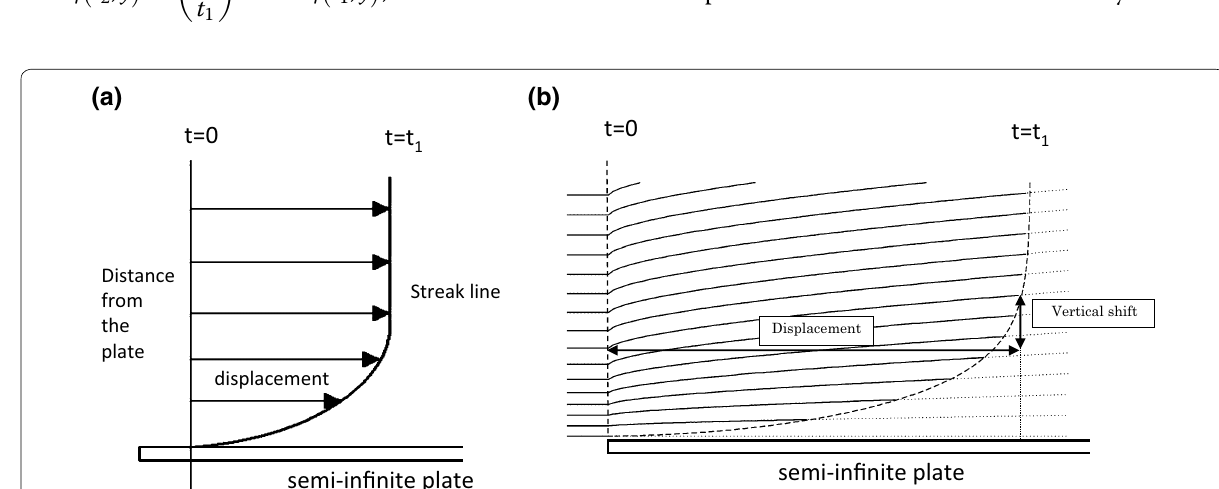
Fig. 3 Illustrations of the “deformation structure” and “displacement structure.” a The profile of a streak line. For each fluid particle, the distance from the plate and the displacement are calculated and plotted. b Non‑dimensional displacement profile (dashed line) for a semi‑infinite flat plate. Solid lines indicate the distance at which each fluid particle is distributed at a right angle to the apical portion of the plate over the defined time period. Dotted lines indicate the stream